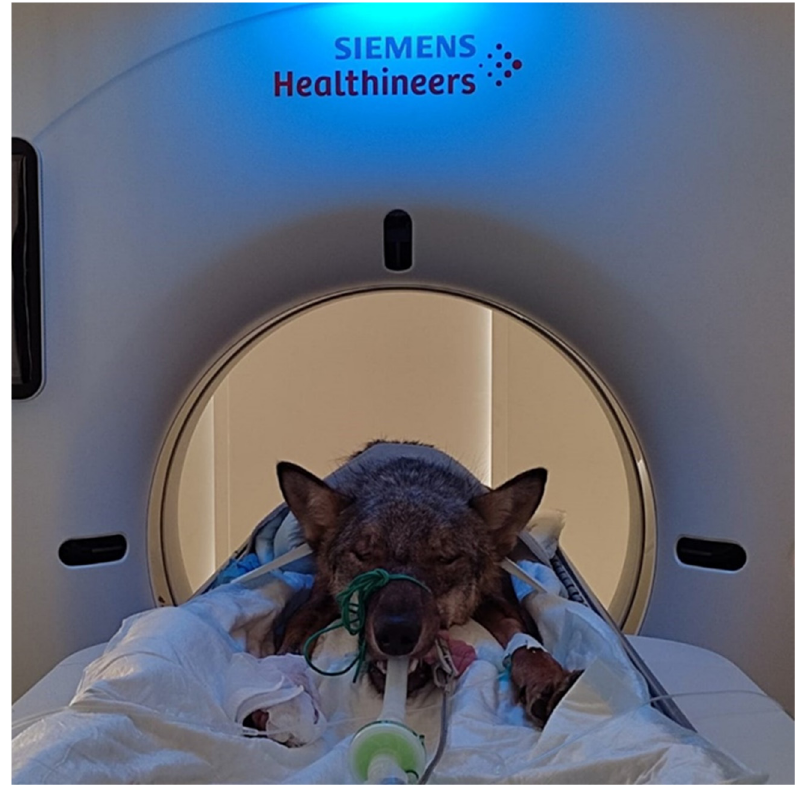
Figure 1. An Italian wolf during a CT